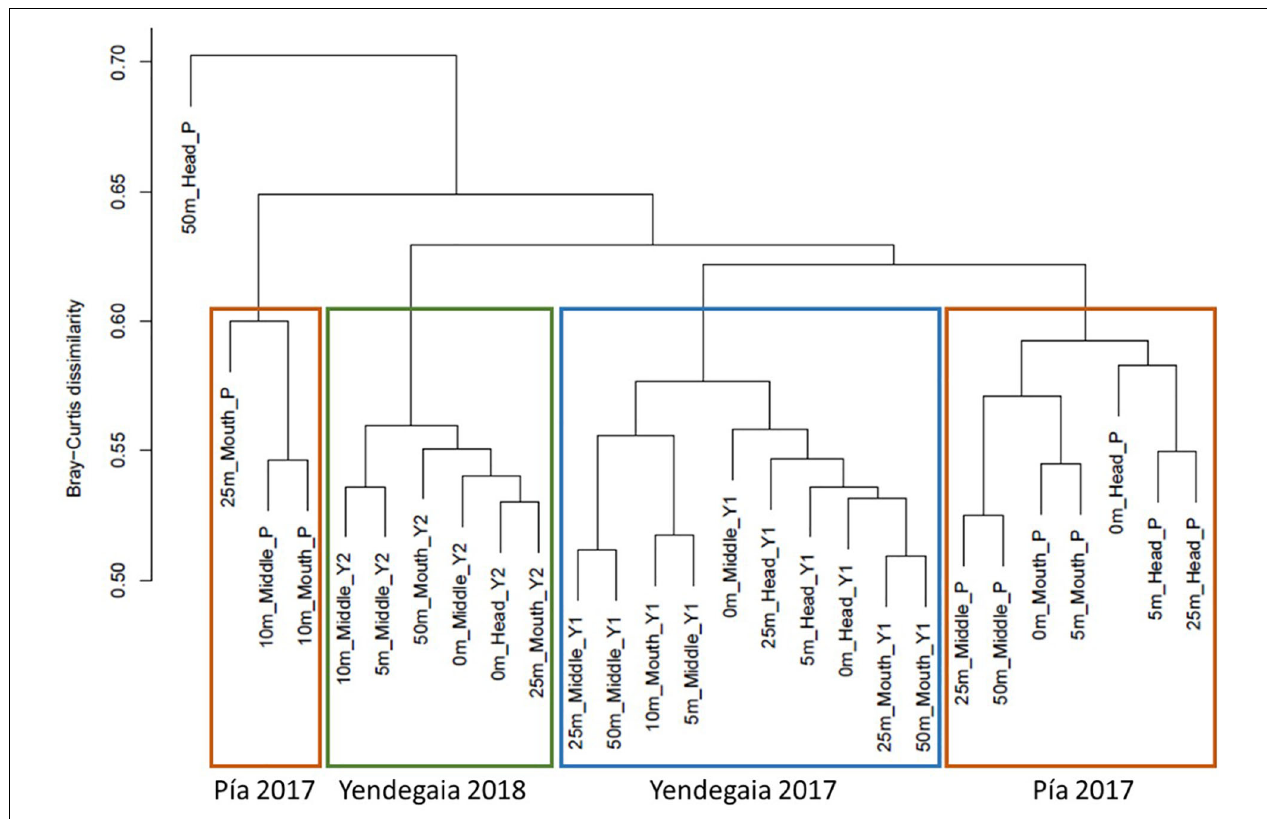
FIGURE 4 | Hierarchical cluster dendrogram based on Bray–Curtis dissimilarity index showing the similarity between microbial community compositions for the RNA fraction in Pia fjord and Yendegaia fjord in 2017 and 2018.